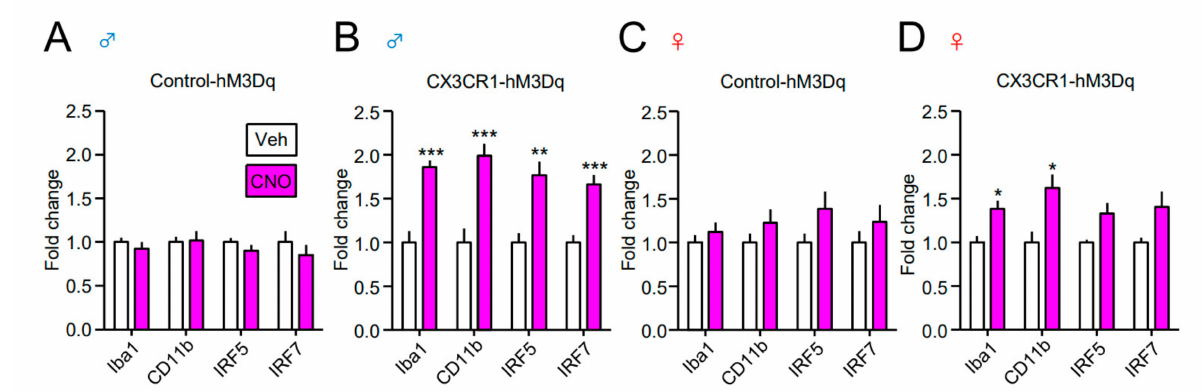
Figure 5. Upregulation of microglial markers in the spinal cord of male CX3CR1-hM3Dq mice. CNO (2 nmol) or Veh was i.t. administered to naïve Control-hM3Dq and CX3CR1-hM3Dq mice of both sexes ( A , B ; male, C , D ; female), and the spinal cord was collected one day after administration. The mRNA expression of microglial markers (Iba1, CD11b, interferon regulatory factor-5 (IRF5) and IRF7) was analyzed by RT-qPCR. Data are presented as mean ± SEM. n = 6 − 9. ***, p < 0.001; **, p < 0.01; *, p < 0.05. vs.